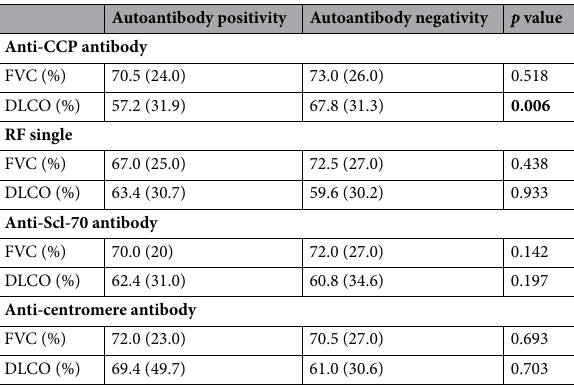
Table 5. Effect of autoantibodies on pulmonary function in SSc-ILD. Bold text indicates statistical significance. Values are expressed as median (IQR). PFT, pulmonary function test; FVC, forced volume capacity; DLCO, diffusing lung capacity of lung for CO; SSc, systemic sclerosis; ILD, interstitial lung